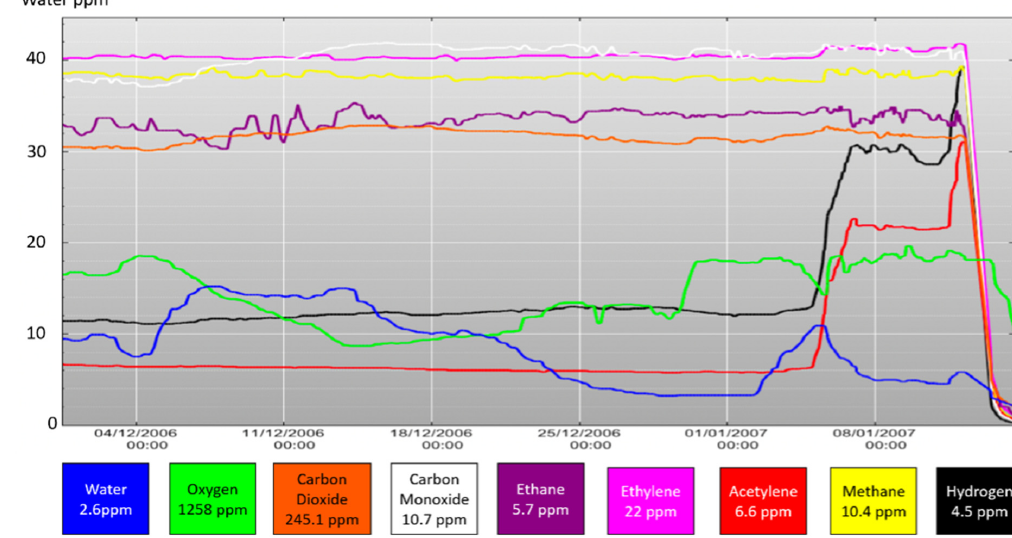
Figure 15. Typical output from an online DGA monitoring system [52].